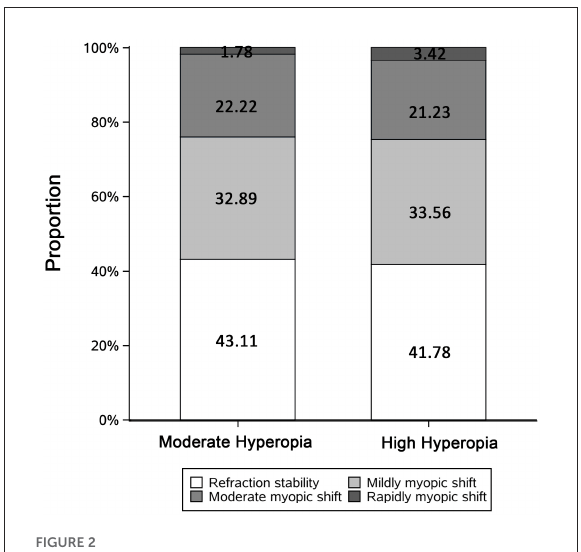
FIGURE2 Bar graph showing distributions of the patterns of refraction development by initial SE. Refraction stability, rate of change in SE < ± 0.25 D/year; Mildly myopic shift, rate of change in SE > − 0.50 and ≤ − 0.25 D/year; Moderately myopic shift, rate of change in SE > − 1.00 and ≤ − 0.50 D/year; Rapidly myopic shift, rate of change in SE ≤ − 1.00 D/year. The numbers represent the proportions of each part.